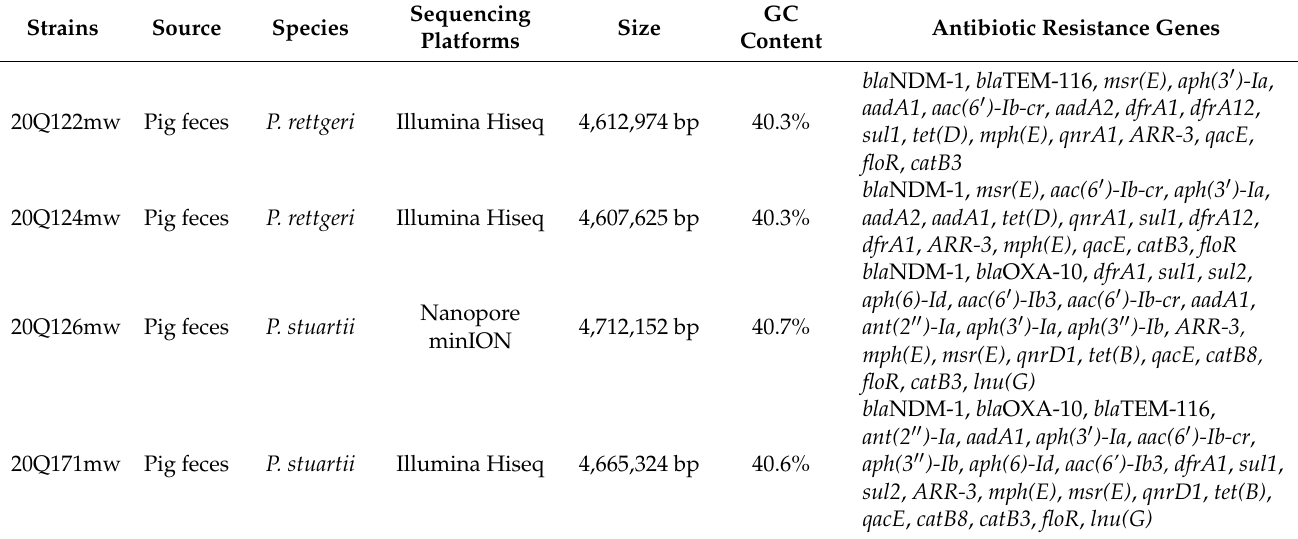
Table 2. Genetic characterization of carbapenem-resistant Providencia